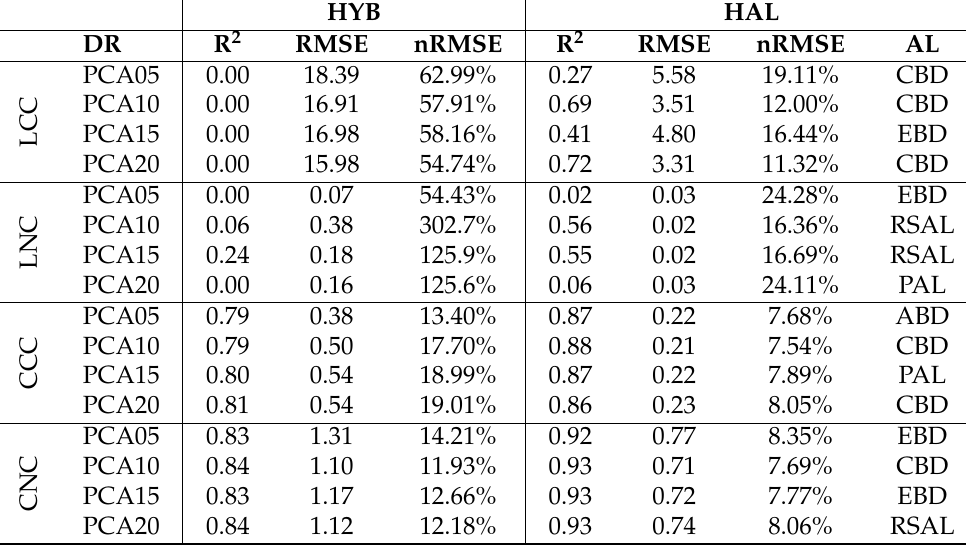
Table 4. Goodness-of-fit metrics for crop trait retrieval using standard hybrid approach (HYB) or hybrid with AL approach (HAL). Statistics are expressed as coefficient of determination (R 2 ), Root Mean Square Error (RMSE) and normalized RMSE